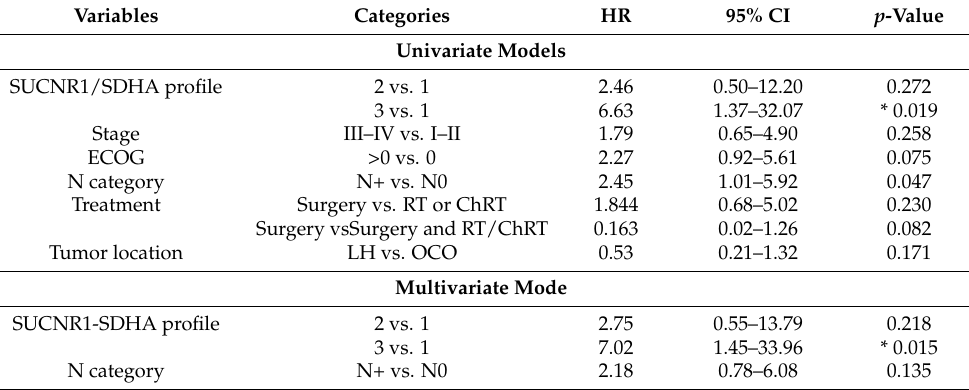
Table 4. PrognosticFactorsofLocoregionalControlinUnivariateandMultivariateCoxRegression